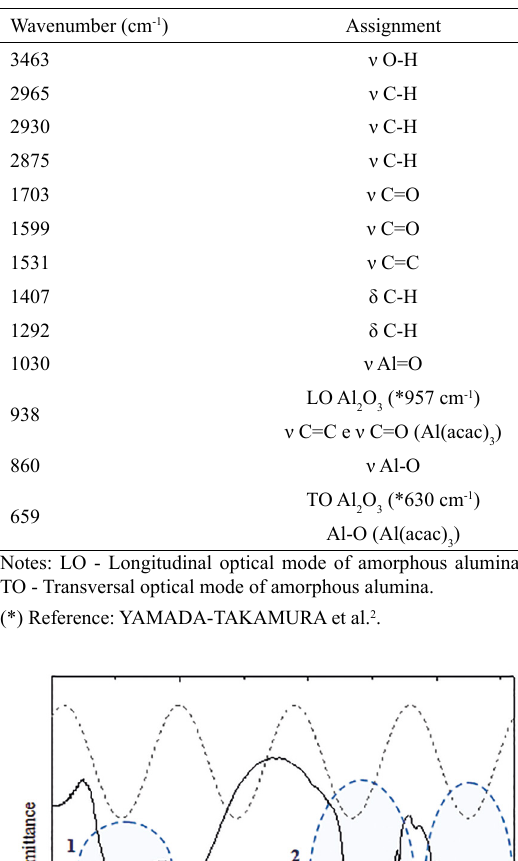
Table 1. Wavenumber of the absorption bands present in the infrared spectra of the films deposited with different duty cycles as well as their assignments.